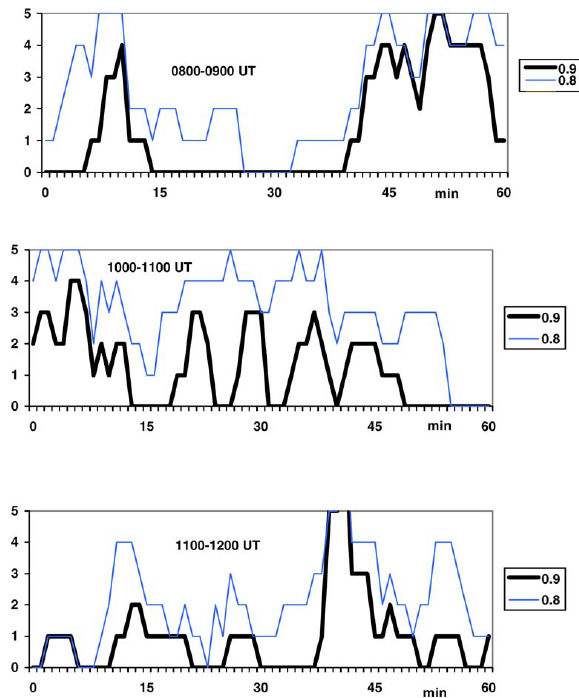
Fig. 5. Number of amplitude-vector groups (from 10 values each) of the filtered 24 s amplitudes (FLR period) from the possible maximum of 5 when the coherence limit 0.9 (thick line) and the 0.8 limit (thin line) was surpassed.